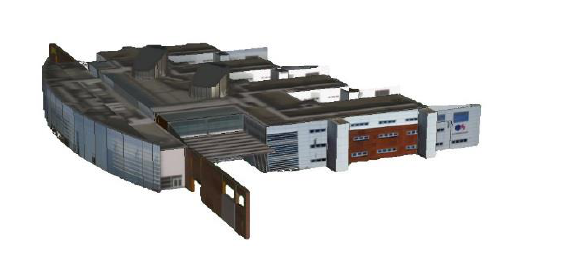
Figure 4. OS Explorer House 3D city